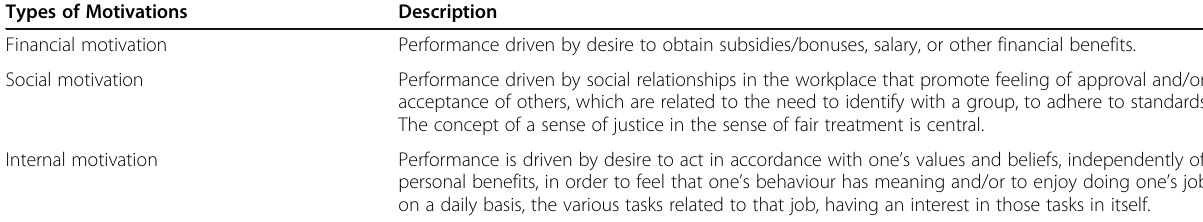
Table 2 Paul and Robinson ’ s classification of health worker motivation